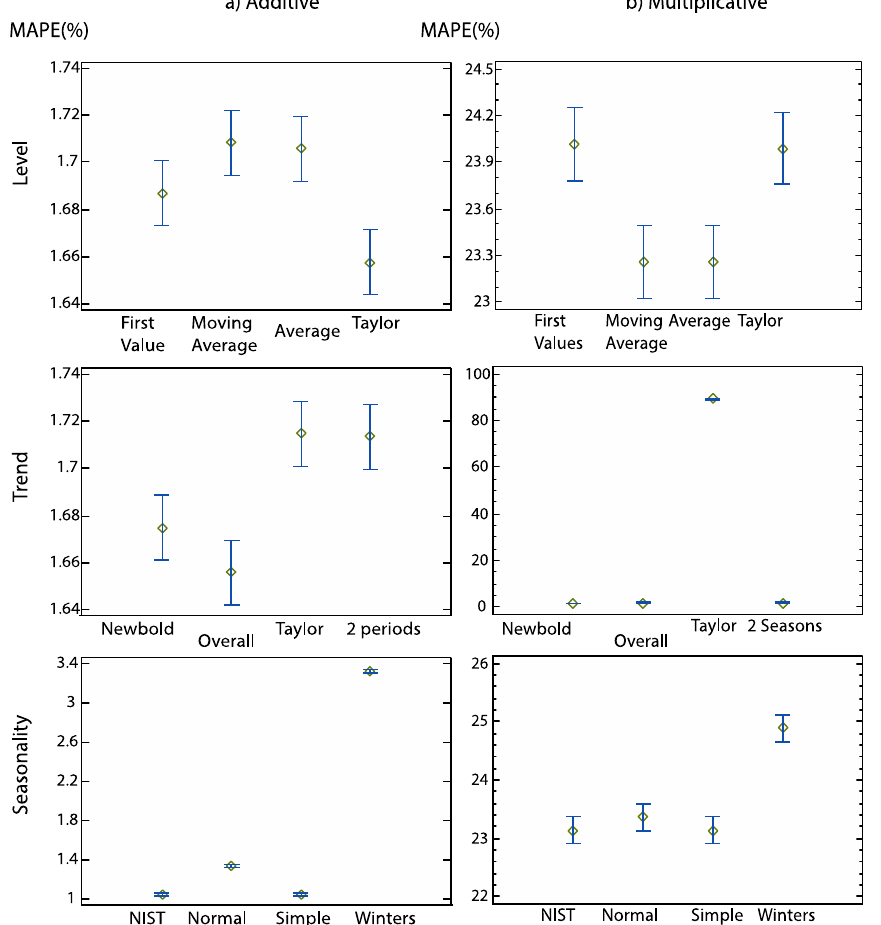
Figure 3. Mean graphs for the MAPE according to the initialization methods analyzed. Left column: Additive trend methods, right column: Multiplicative. From top to bottom: Level, trend, and seasonality. The levels used are those described in Table 4.